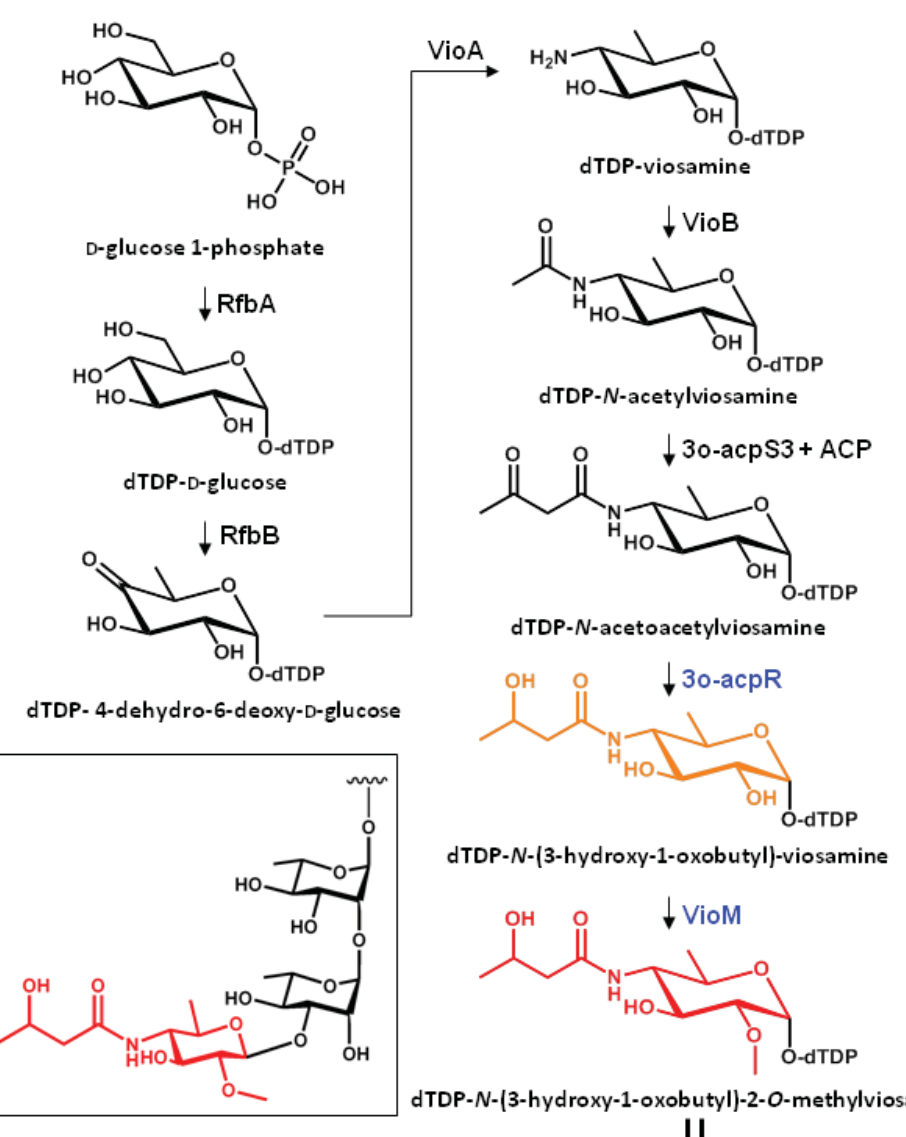
Figure 3. The metabolic pathway to produce modified viosamine and the structure of glycan attached to S201 in the flagellin (inset). Only the modified viosamine (in red) and the last precursor (in orange) were transferred to the non-reducing end of the rhamnosyl glycan by